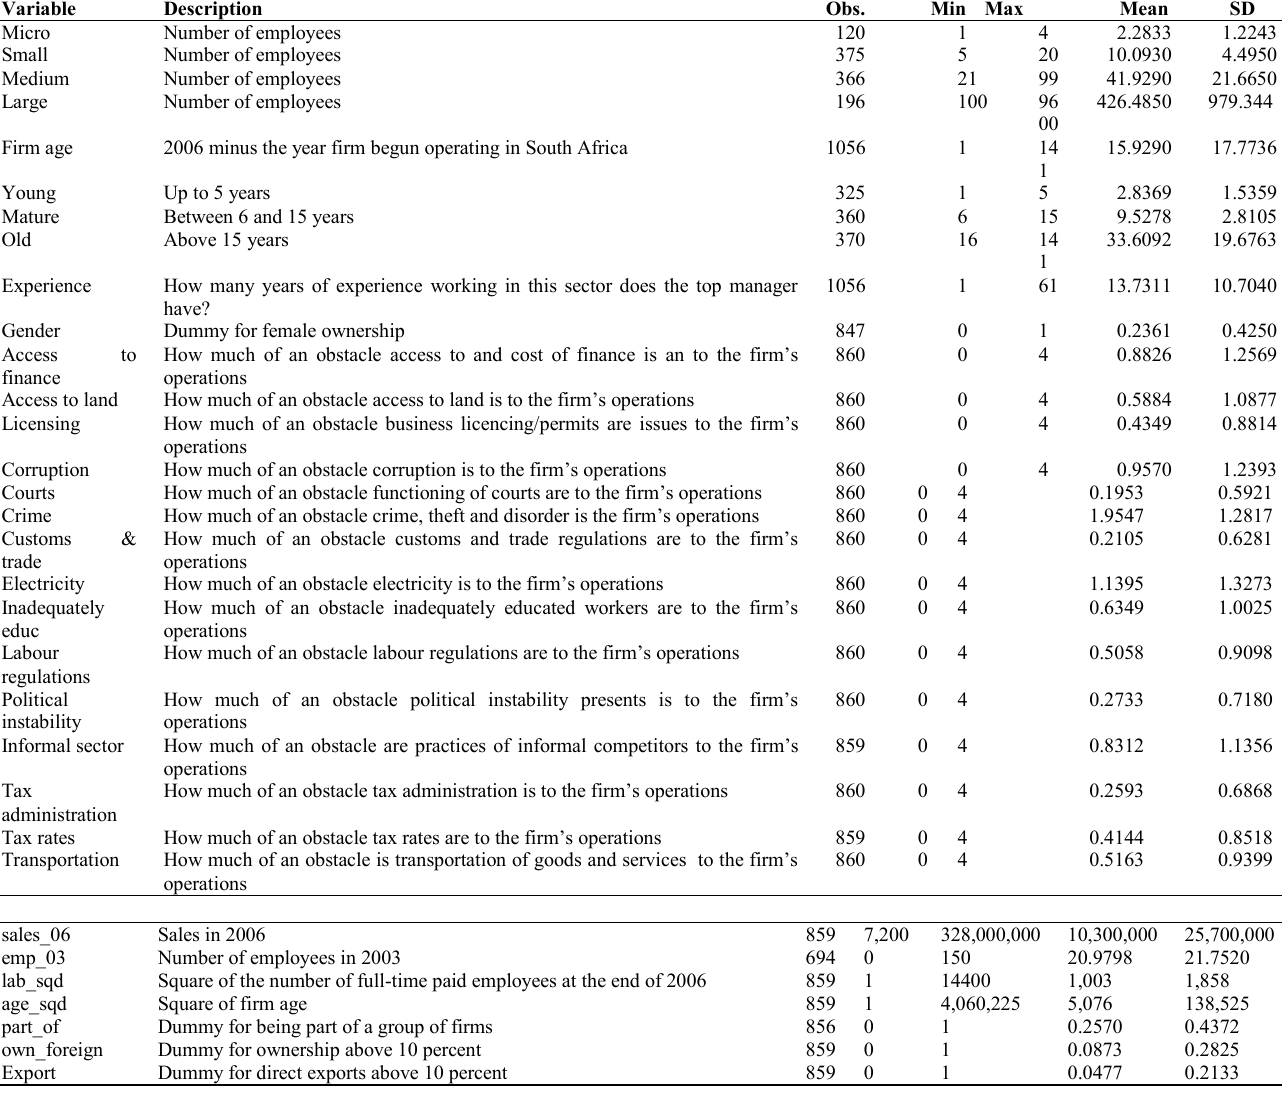
Table 3: Variables descriptions and summary statistics